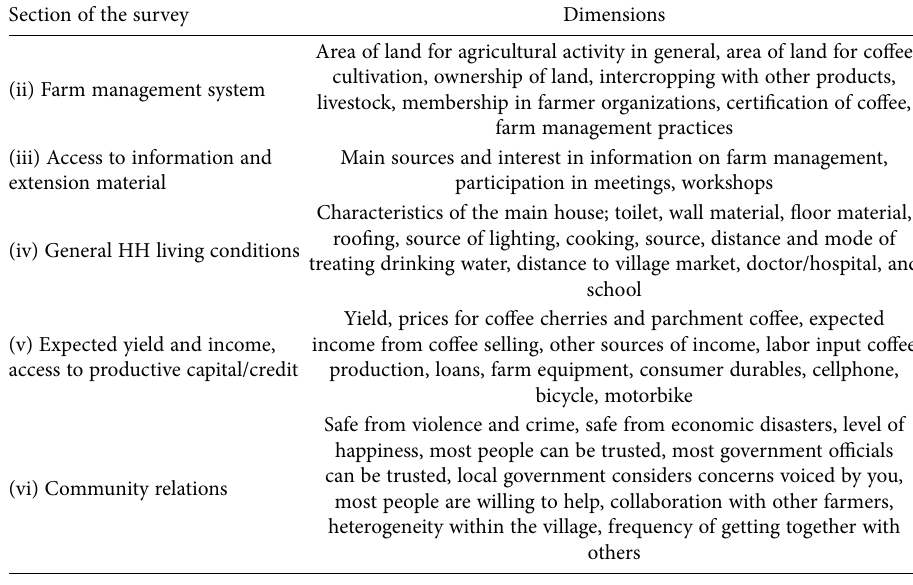
Table 3. Structure of survey sections relevant to wellbeing. Section of the